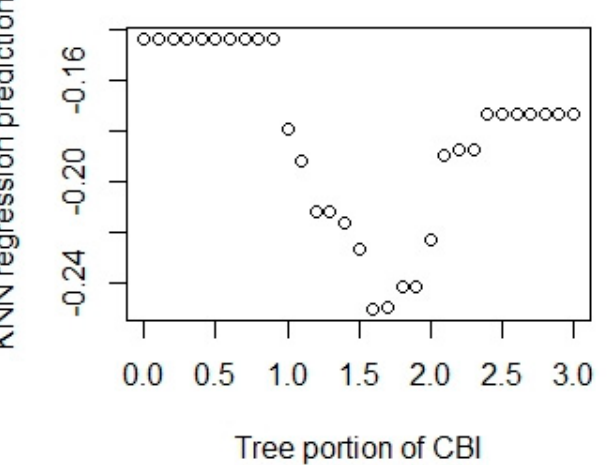
Figure A1. KNN regression predicted difference of FVS-generated canopy cover change minus